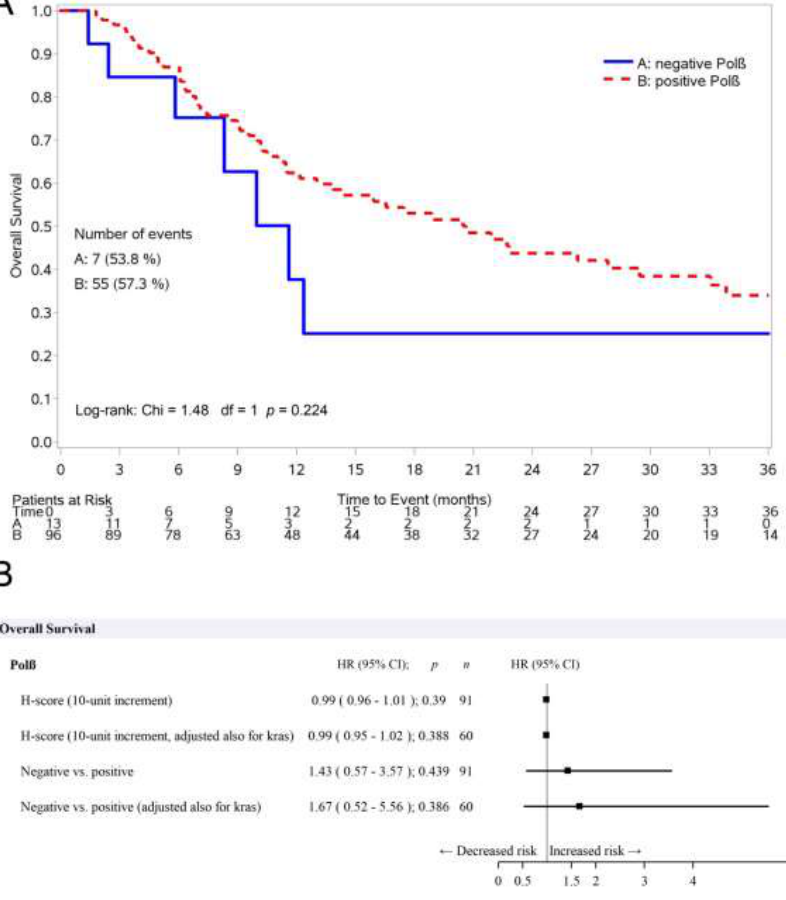
Figure 3. ( A ) Kaplan–Meier curves for OS, according to the positive or negative DNA polymerase β staining. ( B ) Effect of KRAS status on the relationship between Polβ and PFS adjusted for ECOG-PS, age, histology, smoking, therapy, and immunotherapy.